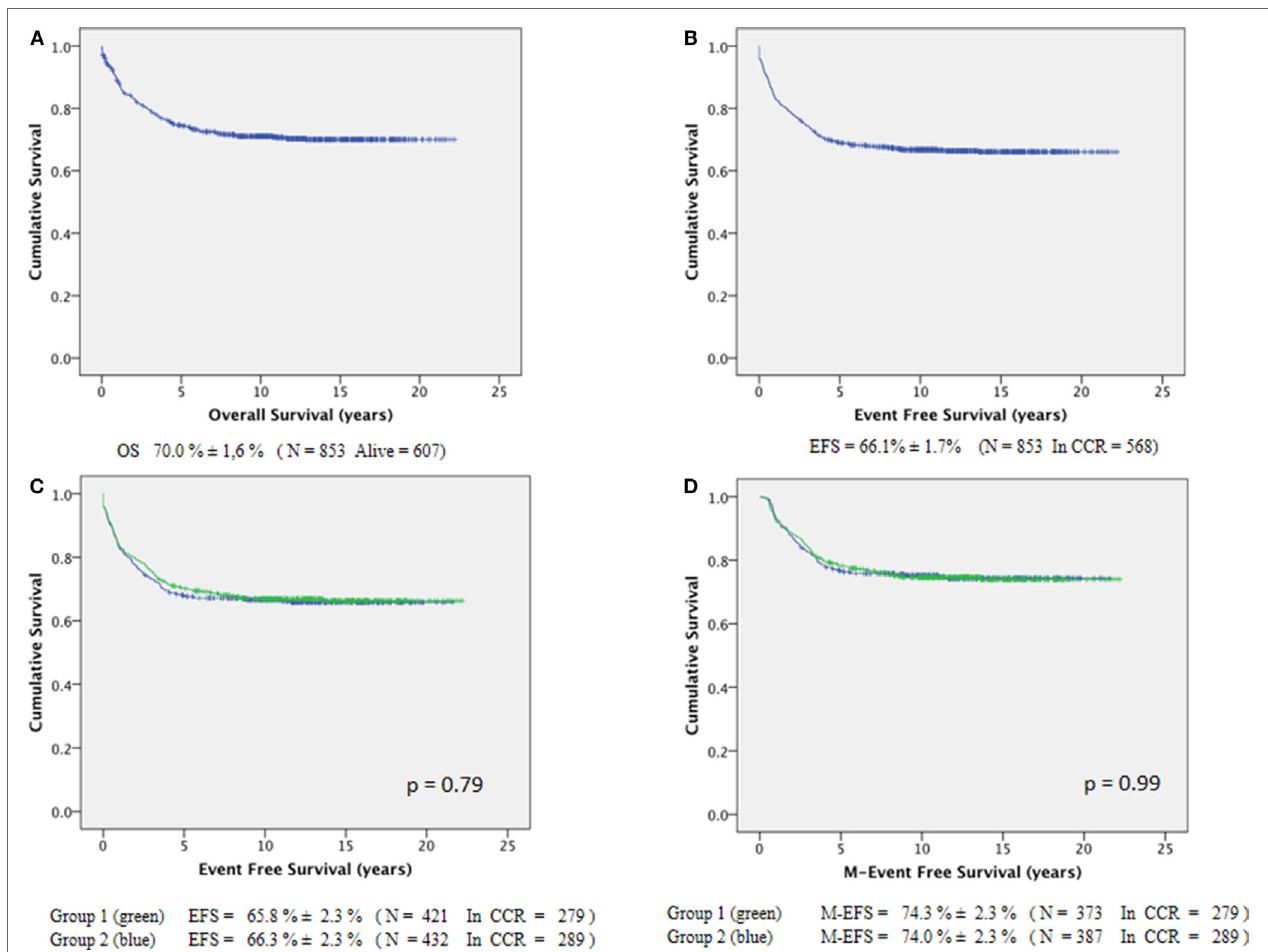
FigUre 1 | long-term survival of 853 all-children treated by gBTli all-93 protocol: (a) overall survival, (B) event-free survival, (c) eFs according to maintenance regimen length, (D) M-eFs according to maintenance regimen length